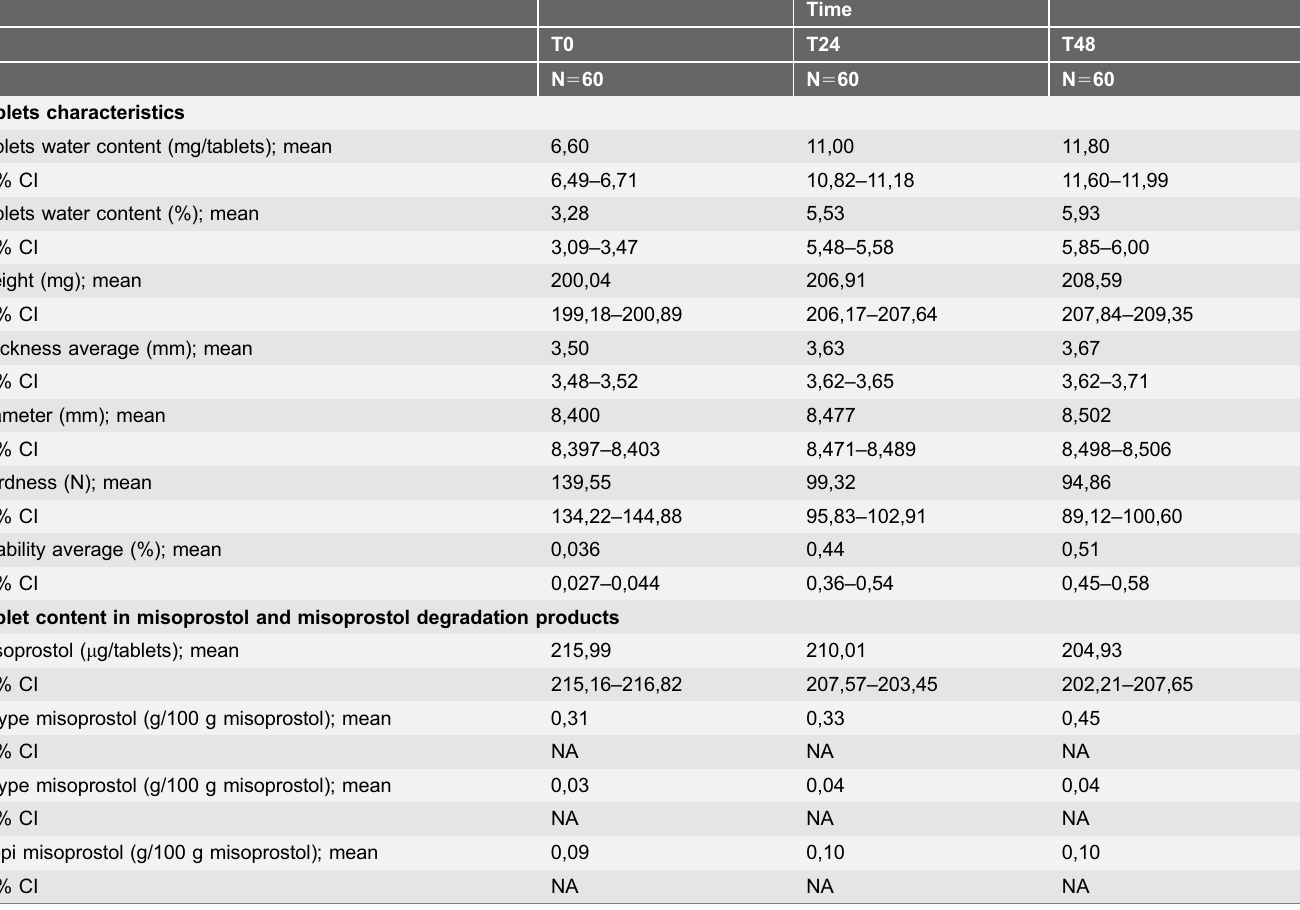
Table 1. Changes in misoprostol tablet characteristics and content in misoprostol and misoprostol degradation products after 24 and 48 h exposition to usual European humidity and room